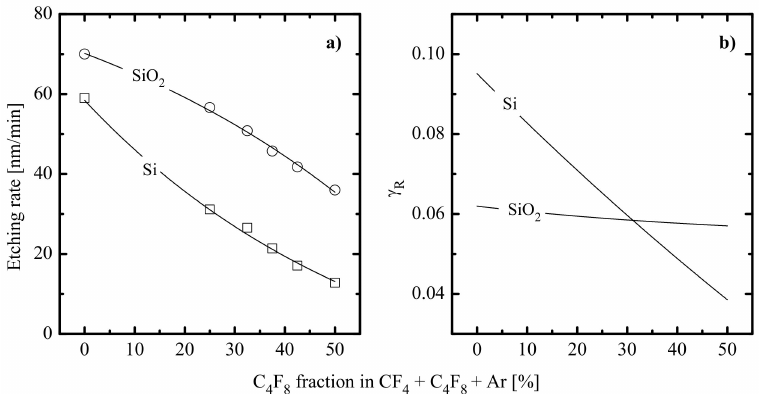
Figure 7. Etching rates ( a ) and effective reaction probability of F atoms ( b ) for Si and SiO 2 in CF 4 + C 4 F 8 + 50% Ar plasma at p = 4 mTorr, W = 800 W and W dc = 150